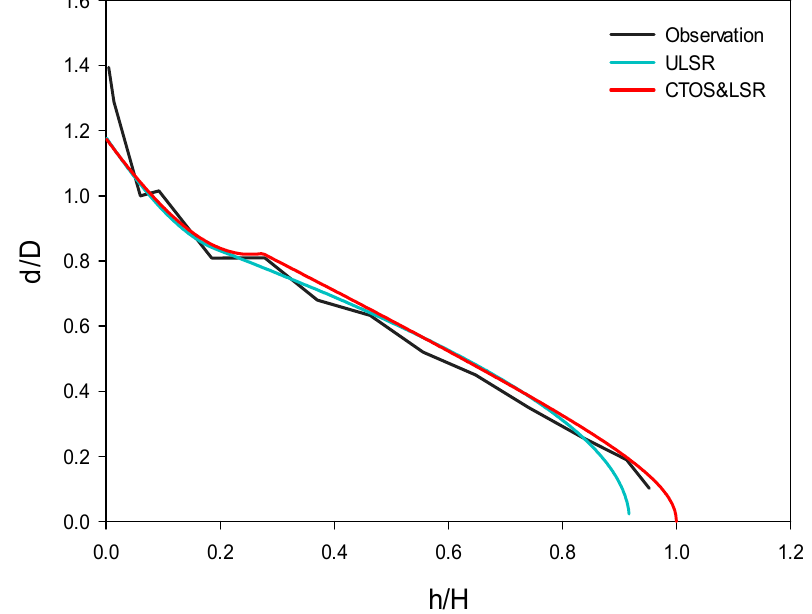
Figure 7. Observed relative outside bark diameters at different relative height location (black line) for an individual tree of E. fordii . The predicted taper curves from the Equation (1) using both the combination method of constrained two ‐ dimensional optimum seeking and least square regression (CTOS & LSR) (red line) and the unconstrained least square regression (ULSR) (blue line) are shown.